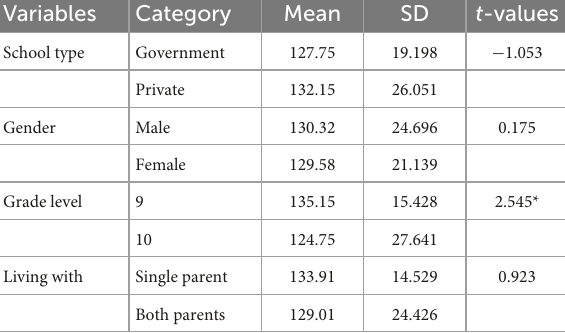
TABLE 3 Mean difference in students’ mathematics self-efficacy based on school type, gender, grade level, and living arrangements.